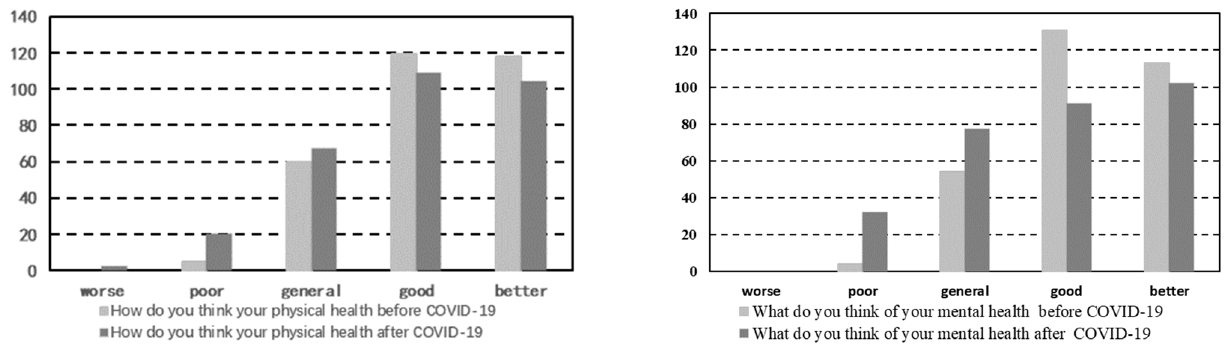
Figure 2. Self-rated comparison chart of physical health ( left ) and mental health ( right ).